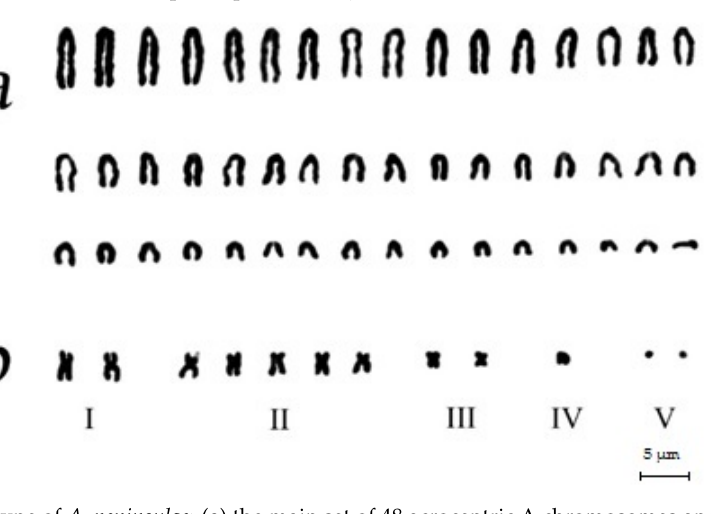
Figure. 3. Karyotype of A. peninsulae : ( a ) the main set of 48 acrocentric A chromosomes and ( b ) variants of five (I–V) classes of B chromosomes. Formulas of Bs are 12.2.5.2.1.2.